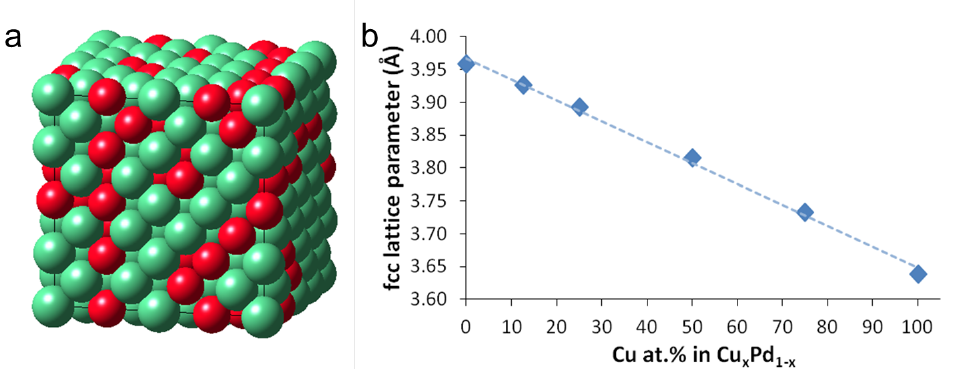
Figure 1. ( a ) Super-cell illustration. ( b ) Calculated lattice parameters for solid state solution of Pd Cu for various compositions x 1 − x x